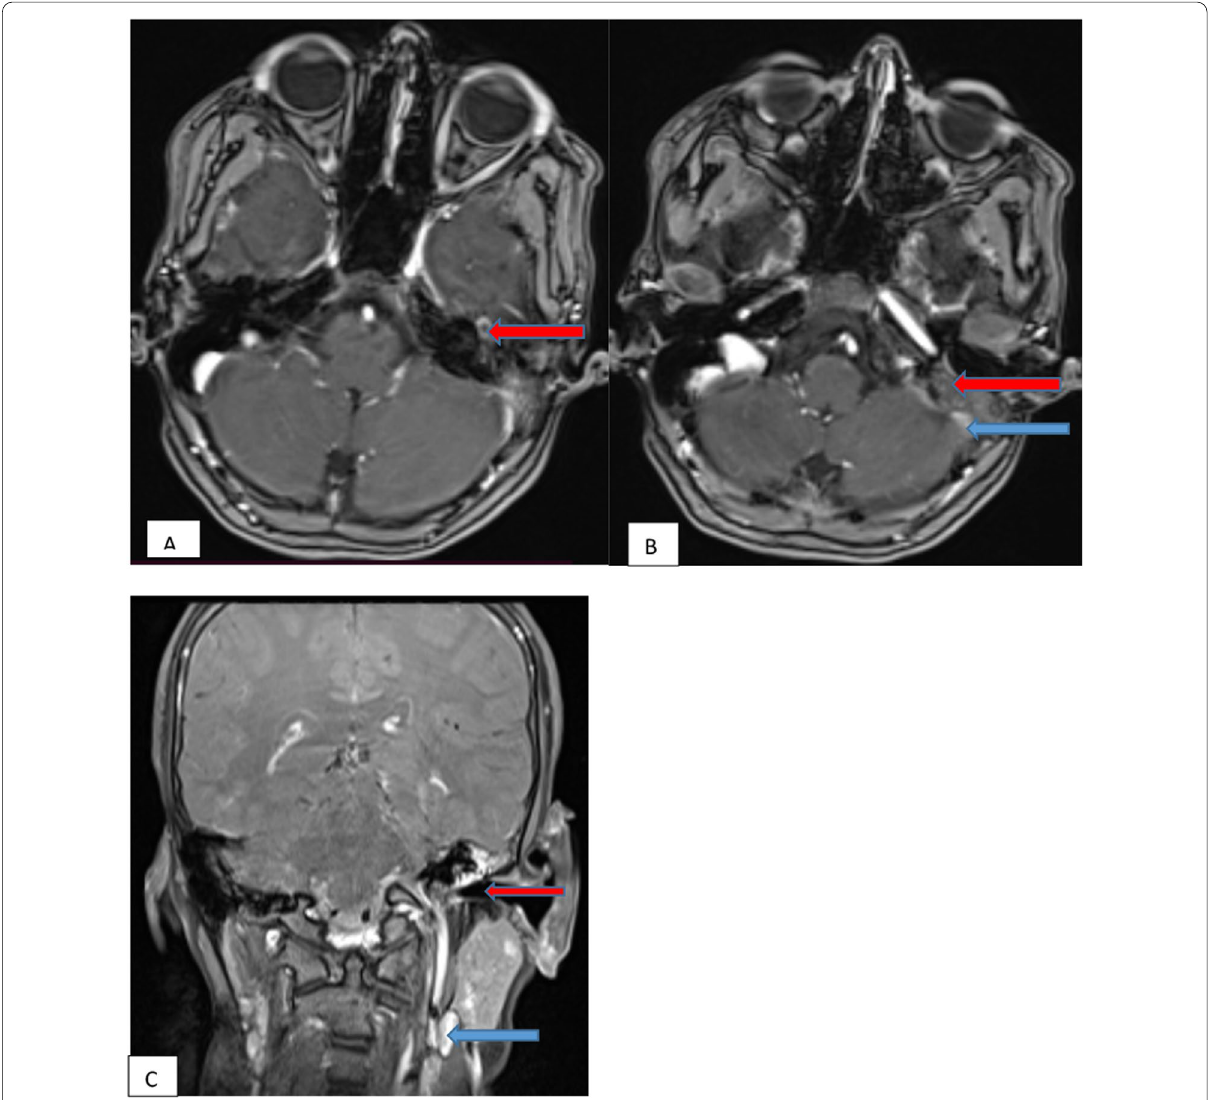
Fig. 6 Post-contrast T1 fat-suppressed MR image at the base of skull after 6 months of treatment shows: A ) Axial section: minimal residual enhancing collection in the petromastoid temporal bone with a significant interval reduction in its extension (red arrow). B ) Axial section: Reduction in extension into the left cerebellopontine angle (red arrow) with narrow calibre and thrombosis of adjacent sigmoid sinus (blue arrow). C ) Coronal section: resolution of soft tissue infiltration in left external auditory canal (red arrow) and reduction in enlarged left cervical lymph nodes (blue